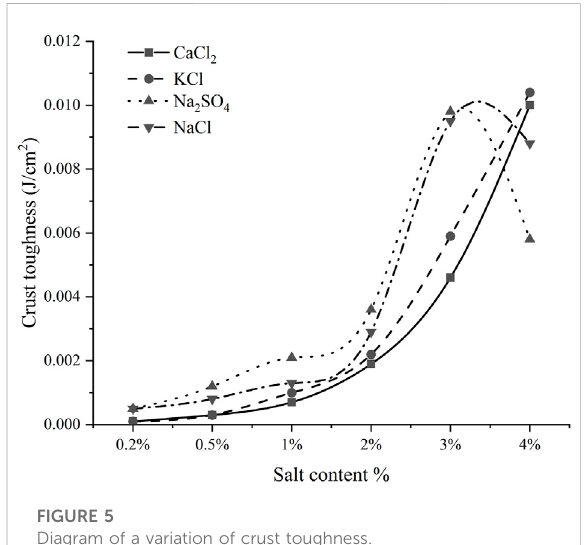
FIGURE 5 Diagram of a variation of crust